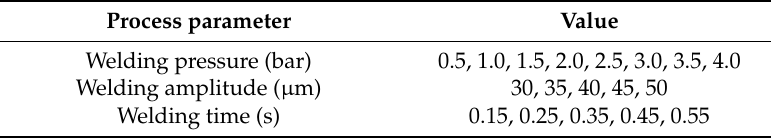
Table 3. Level of process parameters for